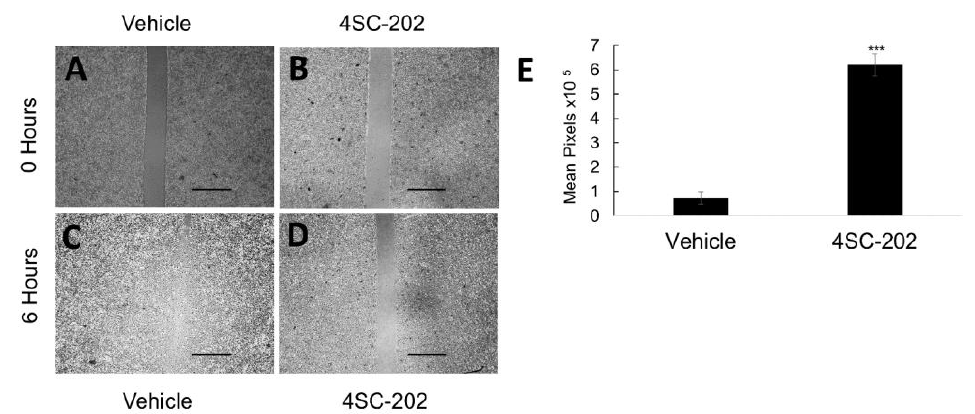
Figure 4. 4SC-202 significantly decreases 4T1 cell migration in scratch assays. Scratch assays were performed on confluent cultures of 4T1 that had either been treated with DMSO ( A , C ) or 4SC-202 ( B , D ). Cultures were photographed at 0 h ( A , B ) and 6 h ( C , D ) after scratch removal. ( A – D ) is imaged with the EVOS XL, scale bar = 2 mm. ( E ) Mean area of each replicate within the scratch region after 6 h ( n = 3). Significance is based on a two-tailed t -test assuming equal variance (adj p < 0.001 ***).